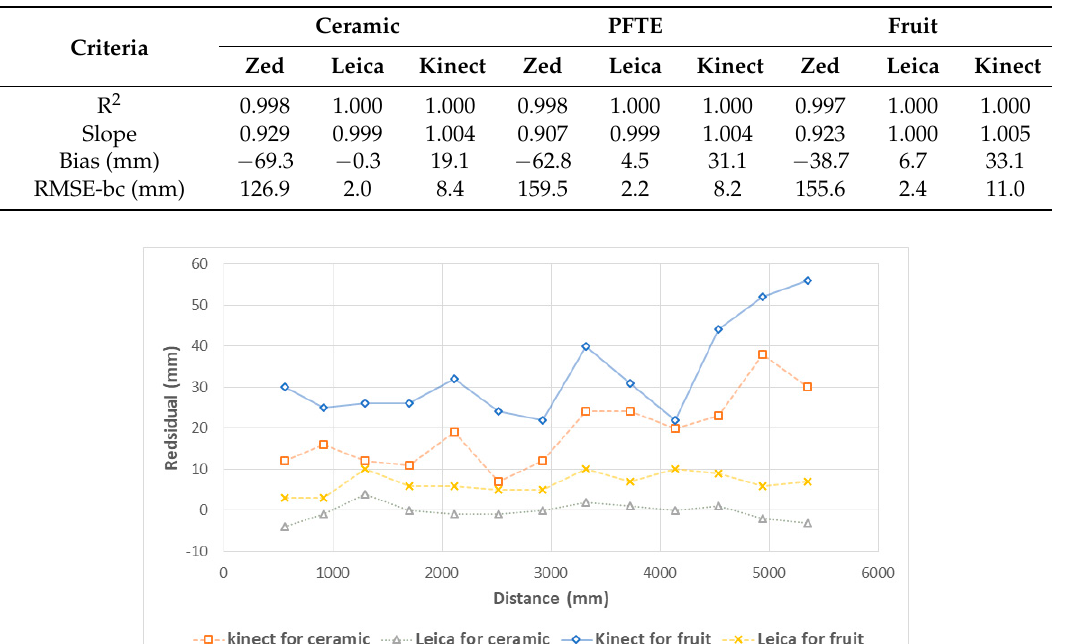
Table 3. Fruit detection using cascade fruit detection and cascade detection followed by ellipse fitting methods for validation set images.